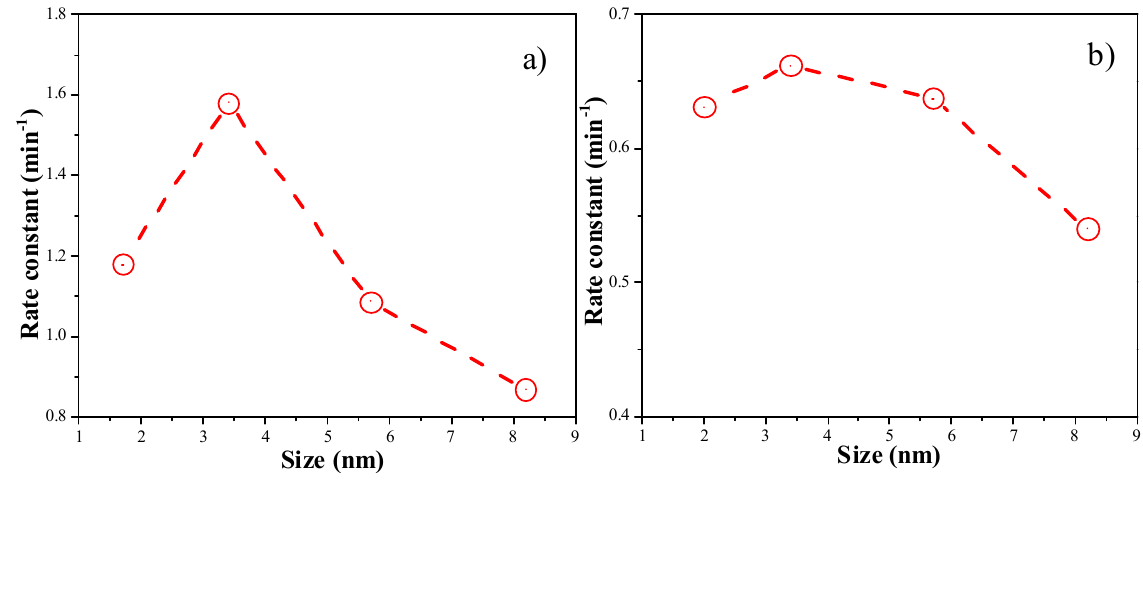
Figure 9. ( a ) the correlation between the rate constants and the Au particle sizes of Au colloids; ( b ) the correlation between the rate constants and the Au particle sizes of Au/Al O 2 3